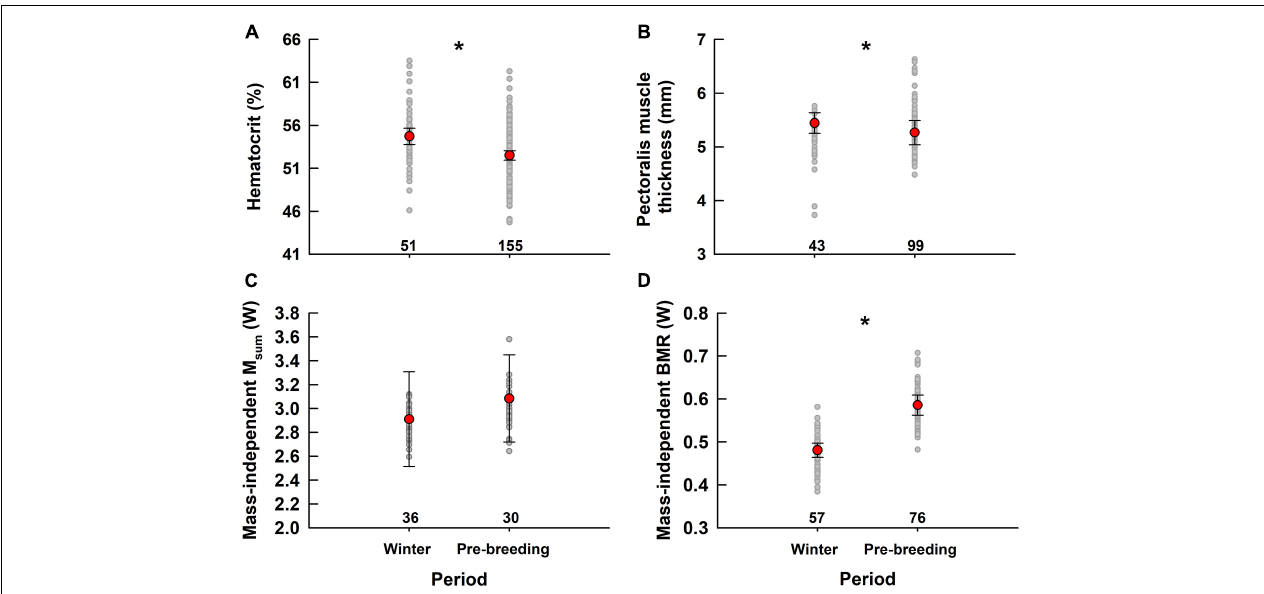
FIGURE 1 | Comparing hematocrit (A) , pectoralis muscle thickness (B) , mass-independent M sum (C) and mass-independent BMR (D) in snow buntings measured in winter in Rimouski, Québec, Canada and during pre-breeding at Alert, NU, Canada. A star indicates significant differences. Numbers indicate sample size for each group. Values in red are least square means ± CI controlling for the random effect of year and for covariates in models including body mass for M sum and BMR, thus making these variables “mass-independent.” Gray dots show data predicted by models including fixed and random